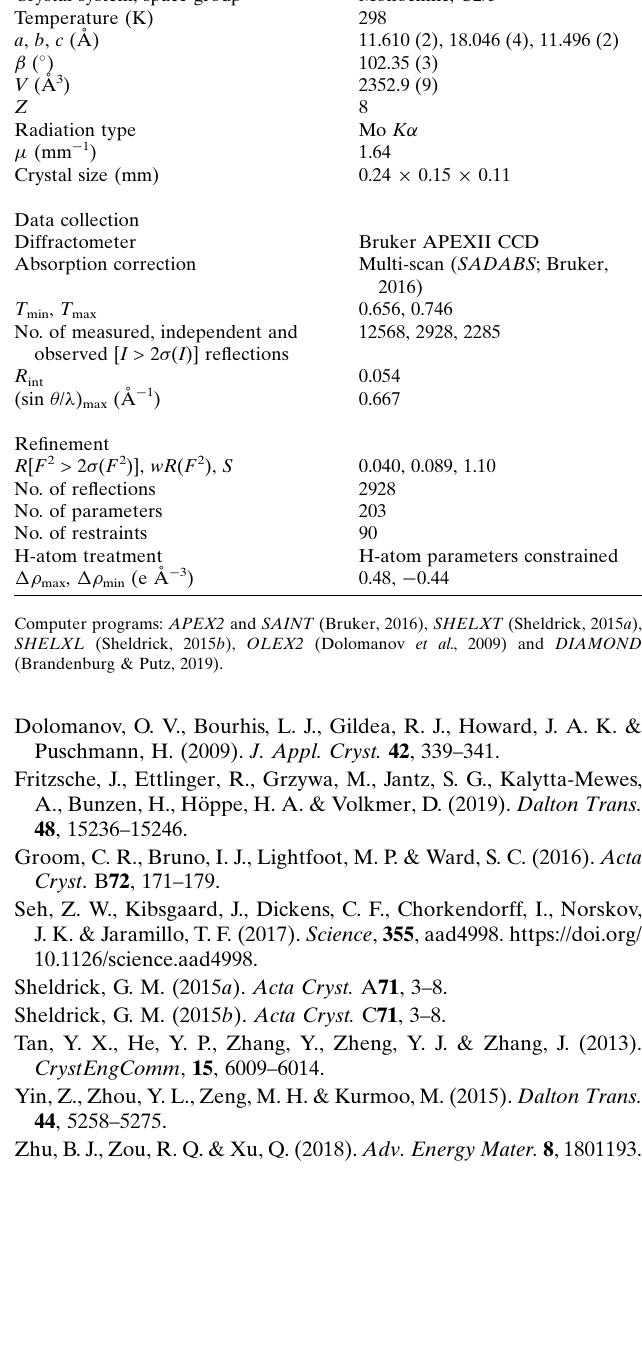
Table 2 Experimental details. Crystal data Chemical